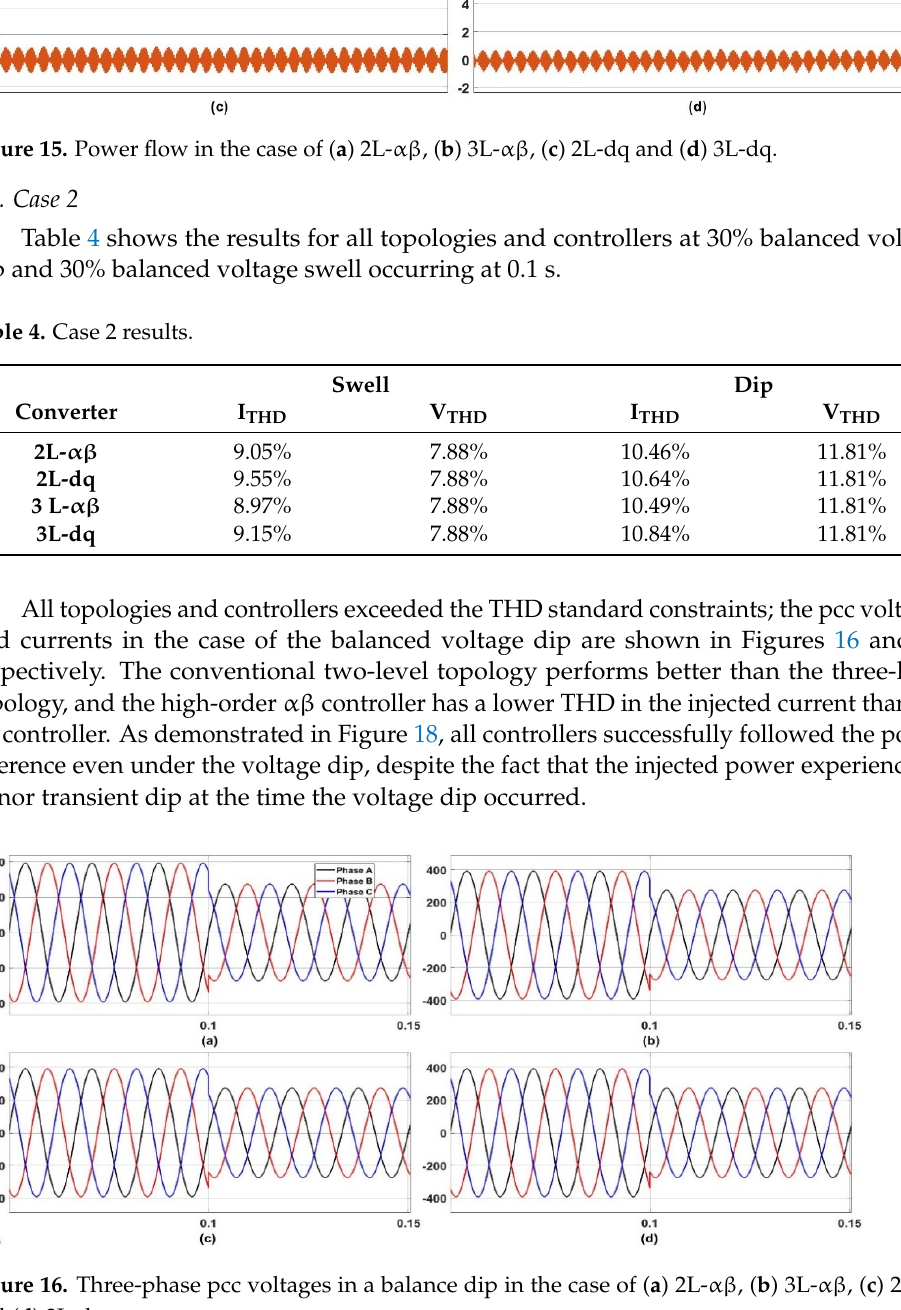
Figure 17. Three-phase pcc currents in a balance voltage dip in the case of ( a ) 2L- αβ , ( b ) 3L- αβ , ( c ) 2L-dq and ( d ) 3L-dq .